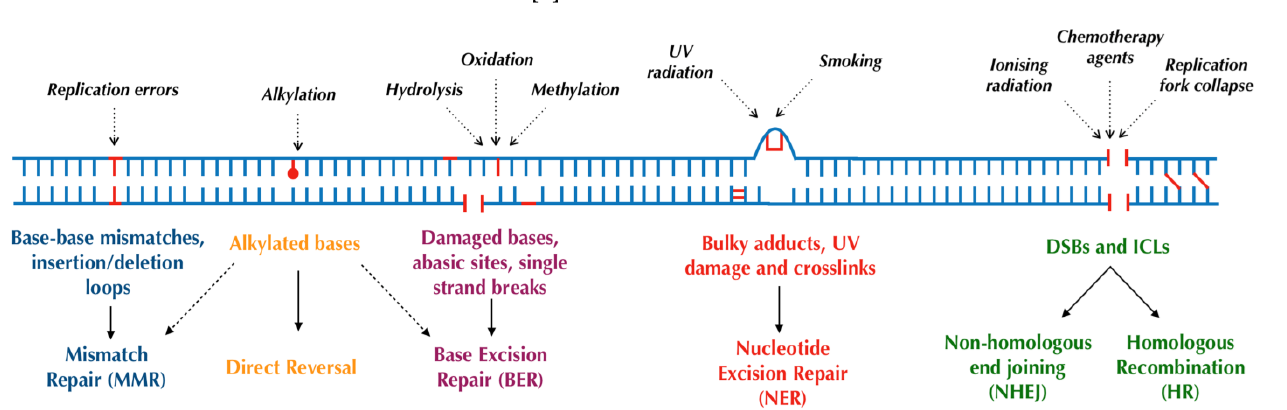
Figure 1. Major DNA repair pathways in mammalian cells.